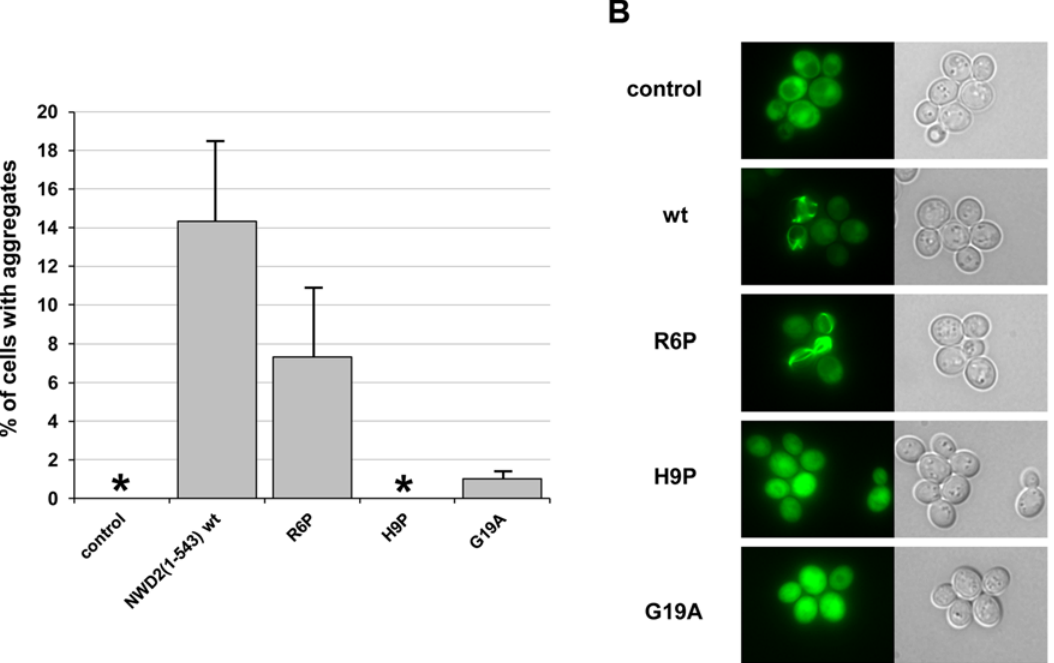
Fig 4. [Het-s] y -prion inducing activity of a NWD2(1 – 534) construct in yeast. A. A yeast strain expressing HET-s(218 – 289)-GFP was either transformed with an empty control vector or a plasmid, leading to expression of NWD2(1 – 534) and three different point mutants of NWD2(1 – 534) as noted. In each case, the fraction of cells containing dot or ring aggregates was determined. Experiments have been carried out at least in triplicates and error bars are standard deviations; the asterisks denote that aggregate formation rate was zero. At least 1,800 cells were counted for each construct, and the p -value of the difference to wild-type calculated as a two-tailed Fisher ’ s test was < 0.001 in all cases. B. Representative fluorescence micrographs of the corresponding cells.